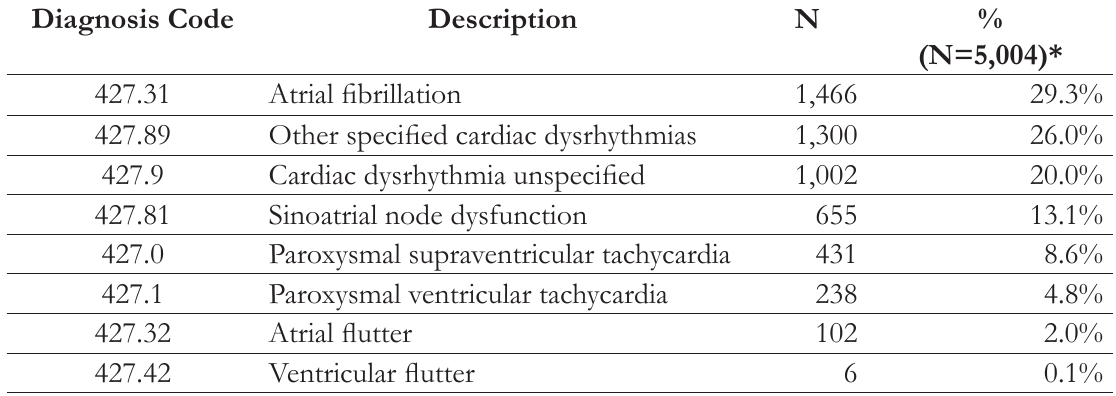
Table 1. Arrhythmia Principal Diagnoses Diagnosis